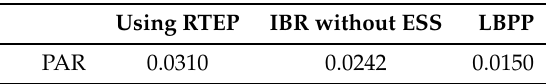
Table 3. PAR comparison.